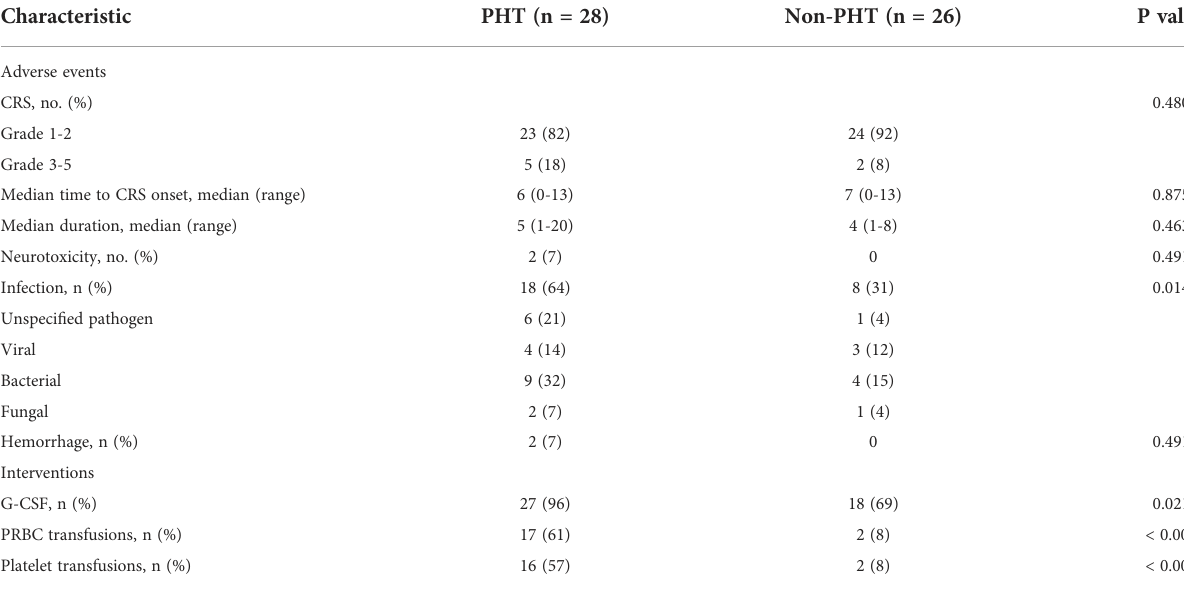
TABLE 2 PHT with other adverse events and interventions after CAR-T-cell infusion.